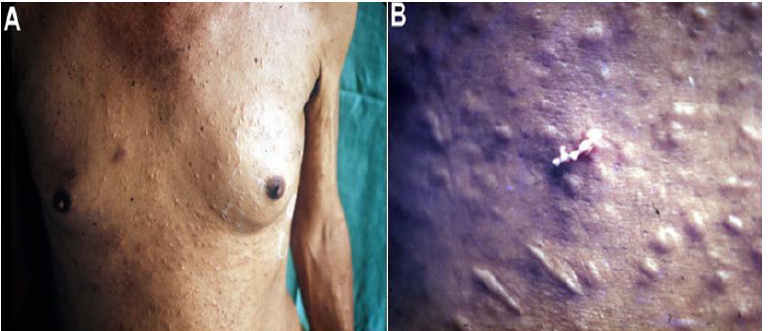
Figure 2. Proliferative sparganosis in a patient showing ( A ) dermal nodules on the chest wall and ( B ) Sparganum proliferum plerocercoid squeezing out of the skin. (This figure is from Kikuchi et al., [15]).